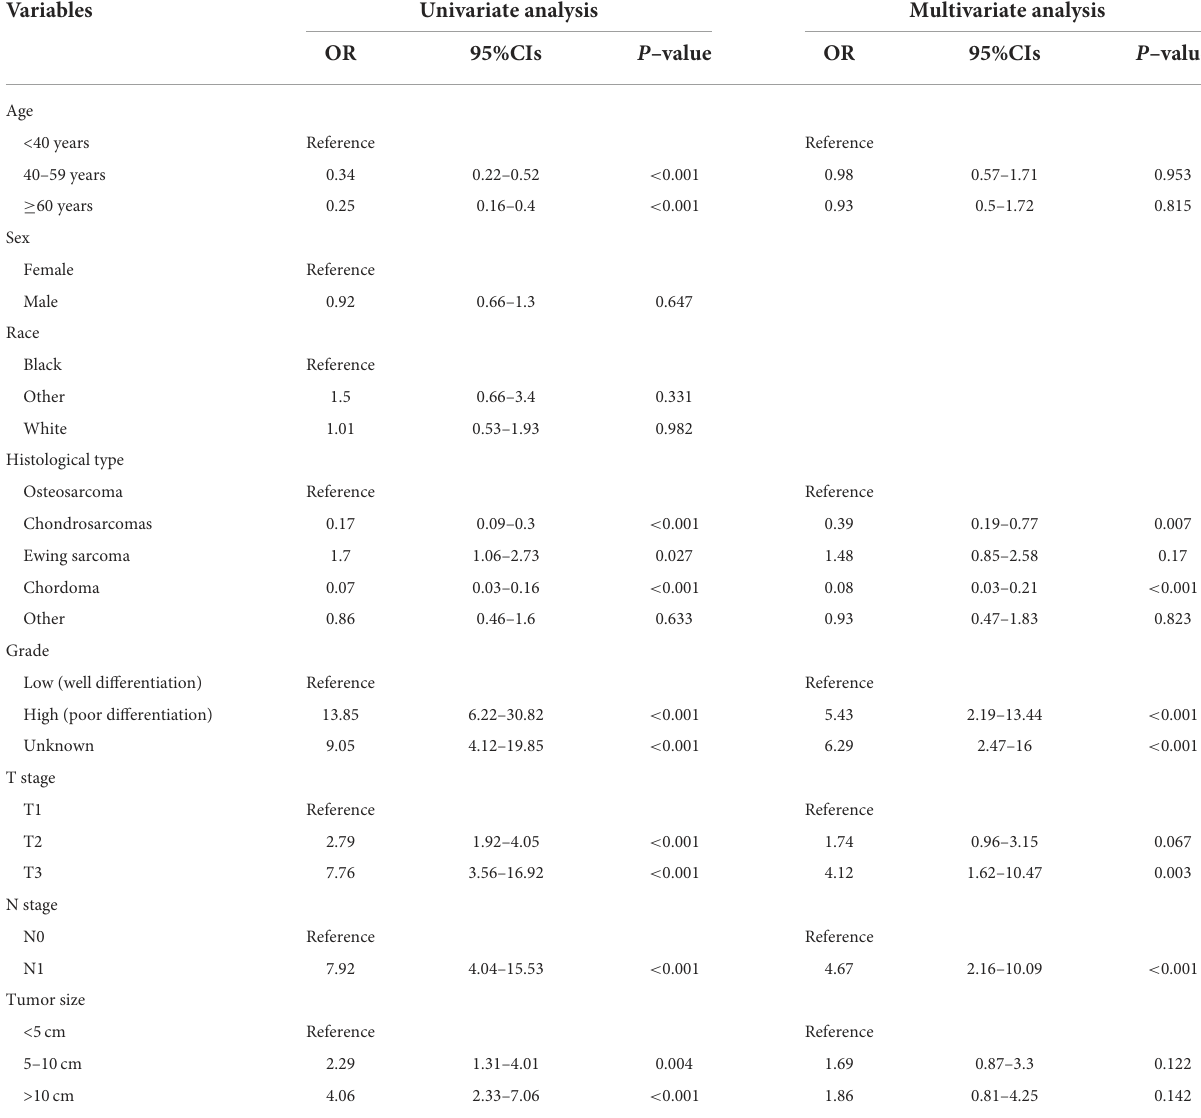
TABLE 2 Univariate and multivariate logistic analysis to determine the independent risk factors of DM in patient with